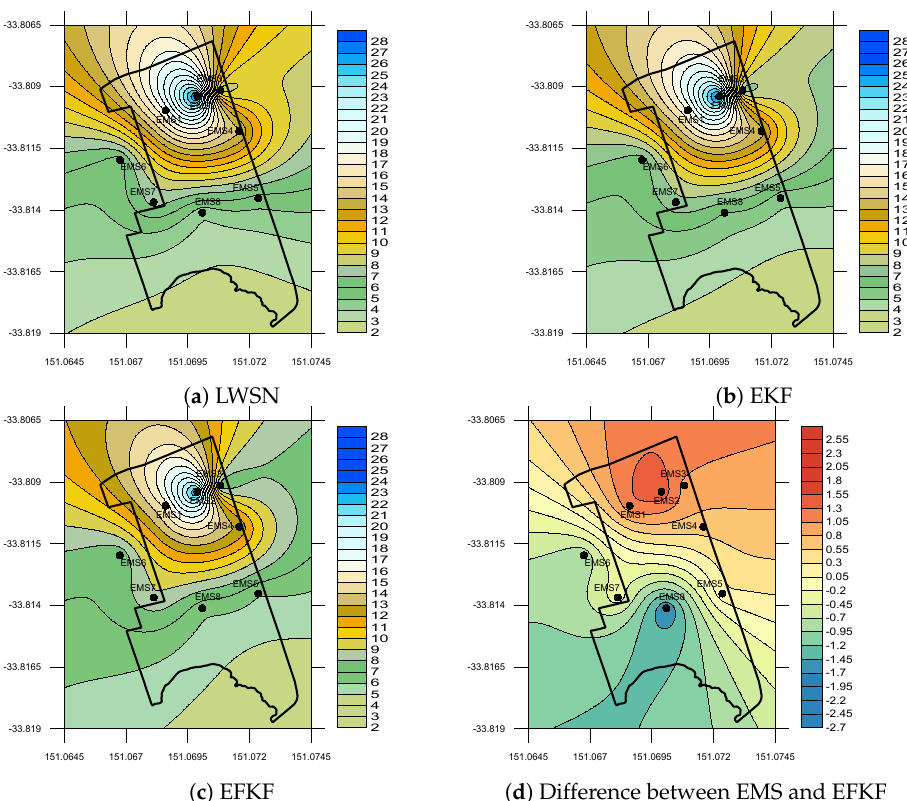
Figure 9. Local PM10 ( µ g/m 3 ) concentration on 18 FEB 2020 at 11:45 am.